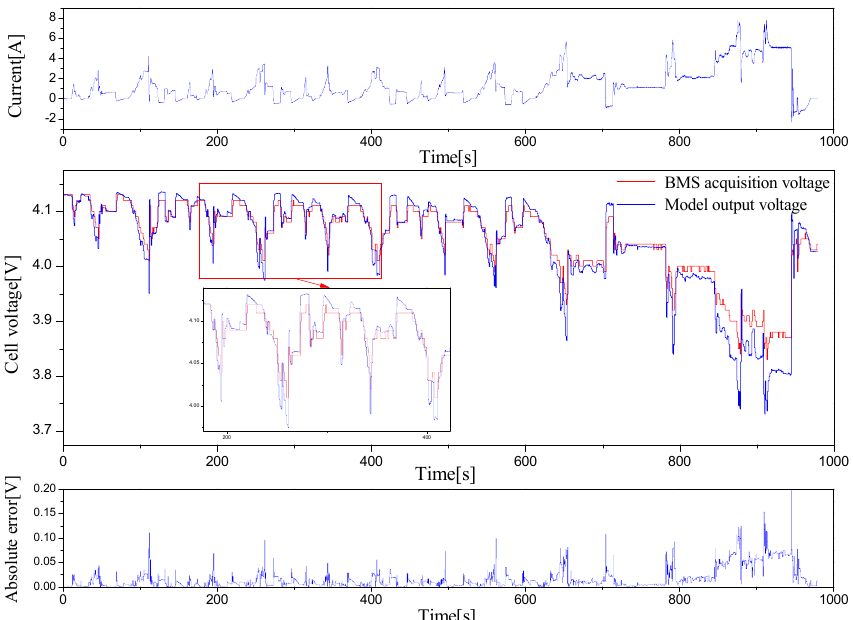
Figure 13. Comparison of model output voltage and actual measured value under NEDC condition.